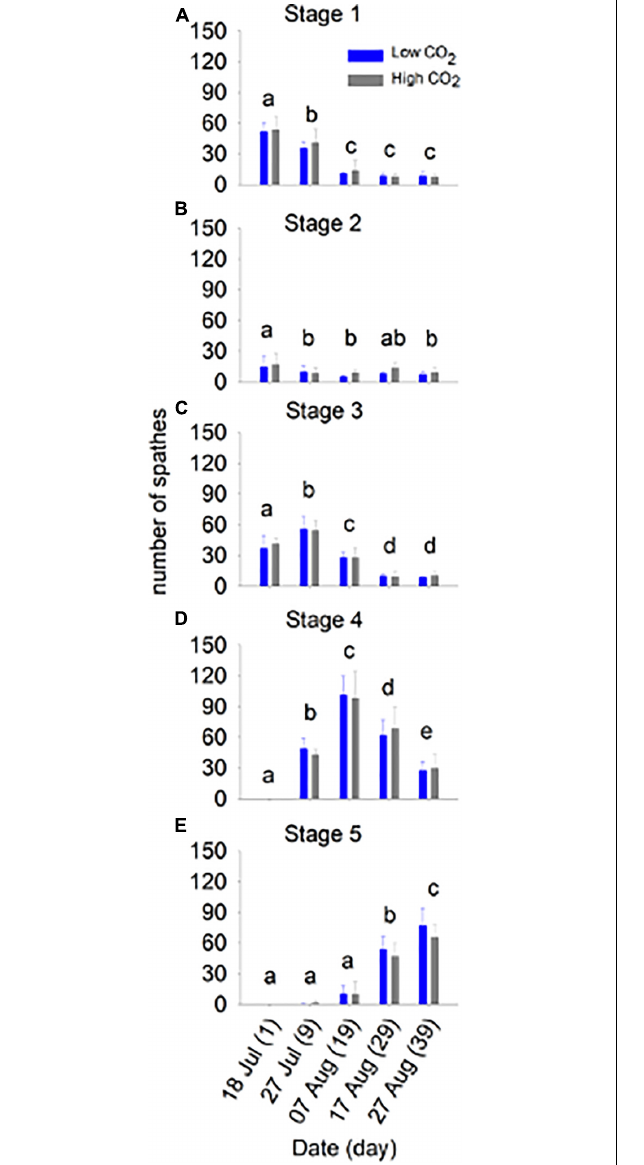
FIGURE 2 | Flower maturation at low and high CO 2 conditions for 39 days (Experiment 1). The number of spathes (mean ± SD) in stages 1–5 (top to bottom) are shown for each day (n). The different letters above bars represent statistical differences between times as specified by the results of a Holm–Sidak pairwise comparison test following a repeated measured two-way ANOVA, Table 2 .